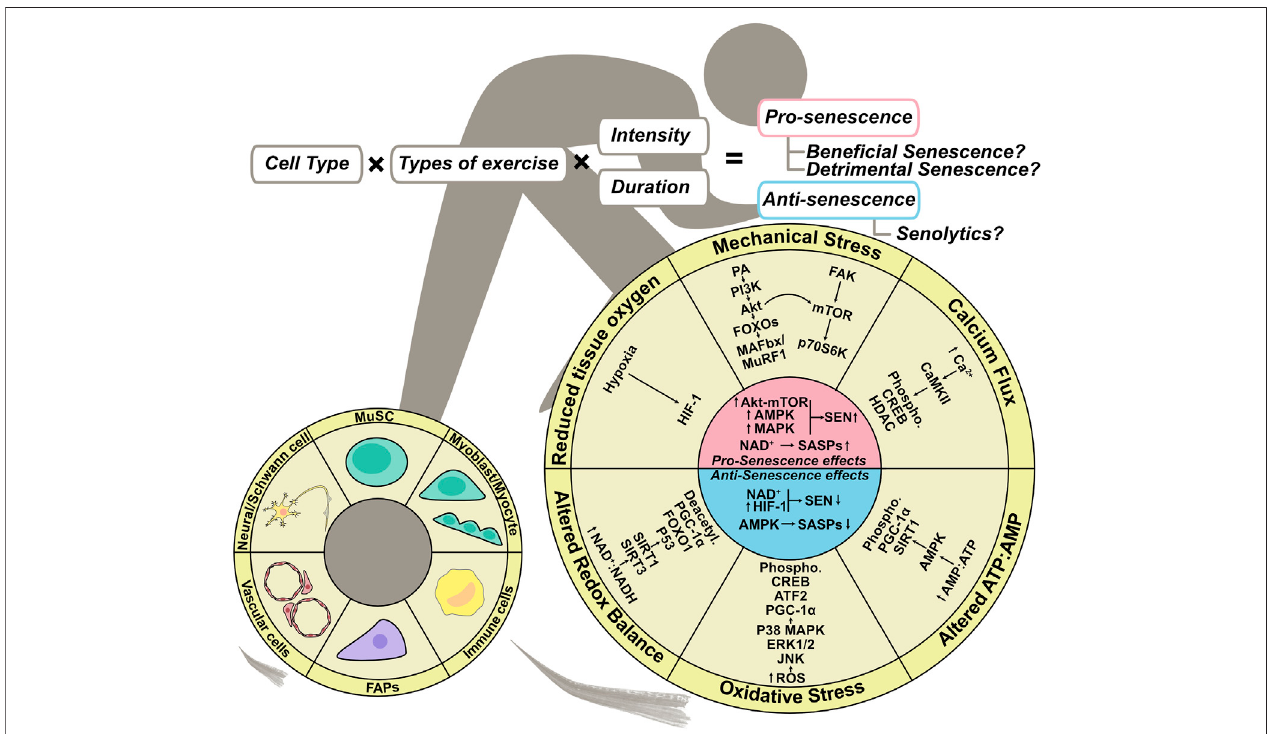
FIGURE 3 | Exercise regulation of senescence in skeletal muscle. Exercise-induced complex stimulation if skeletal muscle can regulate senescence. Mechanical stress, altered ATP:AMP ratio, and oxidative stress – mediated up-regulation of Akt-mTOR, AMPK, and MAPK signaling promote senescence, whereas NAD + metabolism governs SASP expression. On the other hand, altered ATP:AMP ratio, altered redox balance, and AMPK activation mediated by reduced tissue oxygen inhibitSASPexpression, and NAD+metabolism and HIF-1activationinhibitsenescence.Theoutcomeofexercise-inducedmuscle regenerationcoulddepend on cell type, exercise type, and the intensity and frequency, all of which affect senescence.